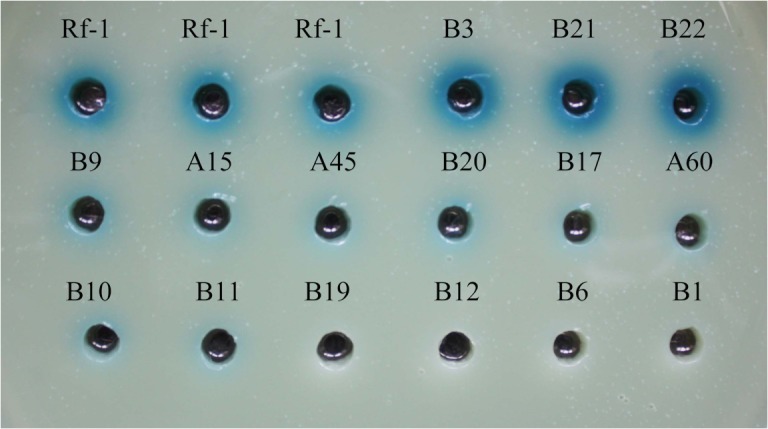
Measurement of LAAO activity from the LAAO-altered or -deficient mutants using Prussian blue agar assay [22].50 μl of culture supernatant of individual mutant or wild-type strain Rf-1 was added into the punched circular hole with a diameter of 6 mm in the Prussian blue agar assay plate for color development from Berlin green to blue caused by H2O2 produced by LAAO activity. The diameter of the resultant blue halo is exponentially associated with the LAAO activity. Compared with wild-type strain, the mutants B3, B21 and B22 had the increased LAAO activities, and the mutants B9, A15, A45, B20, B17, A60, B10 and B11 yielded the decreased LAAO activities, while the mutants B19, B12, B6 and B1 were deficient in LAAO activity.